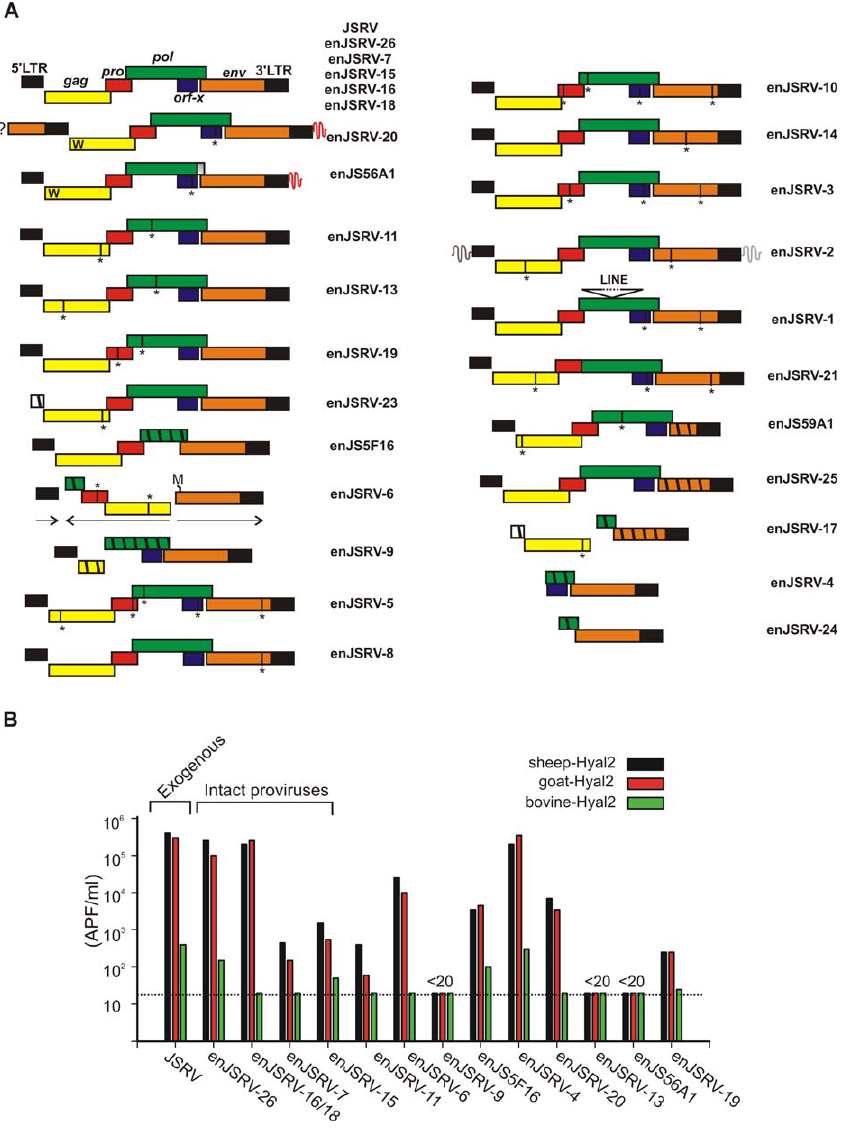
Figure 1. Genomic Organization of the enJSRV Proviruses and Cellular Receptor Usage (A) Genomic organization of the enJSRVs group. Five proviruses contained the typical intact genomic organization of the replication competent exogenous JSRV (top). The ‘‘ W ’’ in the gag reading frame of enJS56A1 and enJSRV-20 indicates the R21W substitution present in these two transdominant proviruses. Before the proximal LTR, enJSRV-20 contains a portion of an env gene indicated by the red box and a question mark. Stop codons are indicated by vertical lines and an asterisk (*). Large deletions in the proviruses are indicated by hatched boxes. The letter M in enJSRV-6 indicates the position of the first methionine (M) in env after the usual start codon present in the other enJSRV loci and the exogenous JSRV. enJSRV-6 contains a recombined structure with internal sequences present in the opposite direction compared to the 5 9 /3 9 LTRs and the env gene (indicated by horizontal arrows). In all but two (enJSRV-2 and enJSRV-20) of the proviruses with both 5 9 and 3 9 LTR, a 6-bp duplication of the genomic DNA at the site of proviral integration was found that is typical of retroviruses. In contrast, enJSRV-2 has two different genomic sequences flanking the provirus, suggesting that this provirus is the likely product of recombination between two proviruses. enJSRV-20 contained a portion of env before the 5 9 LTR, suggesting either an altered reversed transcription before integration or a recombination event. The 3 9 flanking region of enJS56A1 and enJSRV-20 are essentially identical. enJSRV-1 presents a LINE element within the pol reading frame. (B) Receptor usage of exogenous and endogenous betaretroviruses of sheep. Viral entry assays were performed in NIH3T3 cells expressing sheep Hyal2 (ovine Hyal2), goat Hyal2 (goat Hyal2), or bovine Hyal2 (bovine Hyal2). Cells were transduced with retroviral vectors expressing alkaline phosphatase and pseudotyped with envelopes derived by the various enJSRVs indicated in the figure. Results are expressed as alkaline phosphatase foci per milliliter (APF/ml) and are indicated as , 20 when the titer was less than 20 APF/ml.